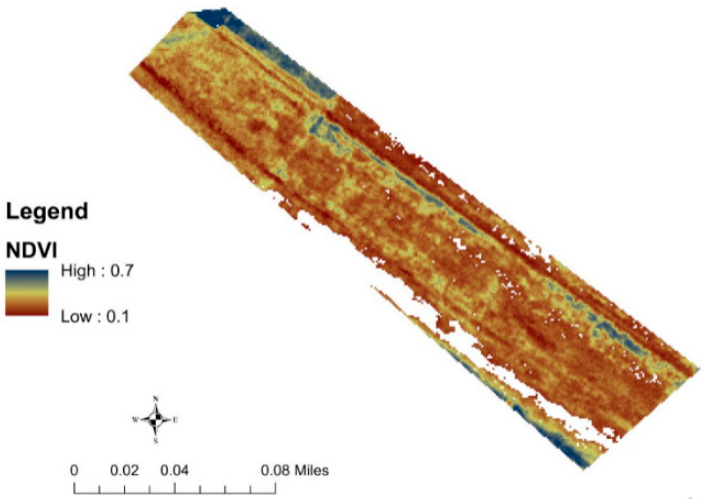
Figure 6. Pasture normalized difference vegetation index (NDVI) pre-flooding.